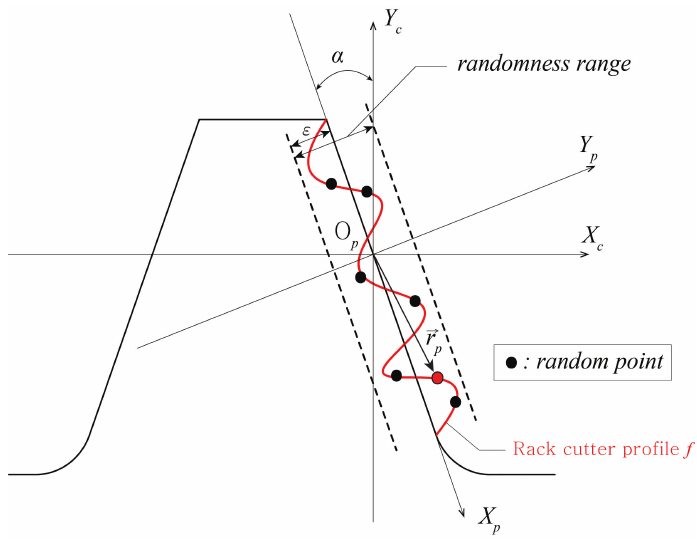
Figure 5. Coordinate system of rack cutter profile with